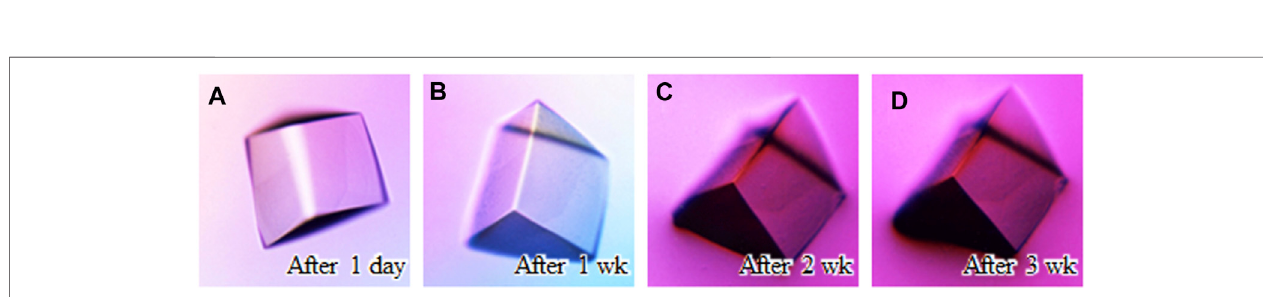
FIGURE 4 | Soaking experiment using a distilled water. Crystal images (A) after 1 day soaking, (B) after 1 week, (C) after 2 weeks, and (D) after 3 weeks are shown.